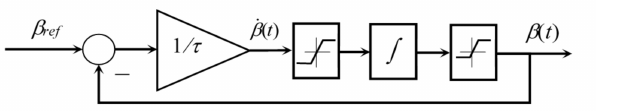
Figure 17. Model representation of a first order pitch actuator without controller and pitch angle set point.